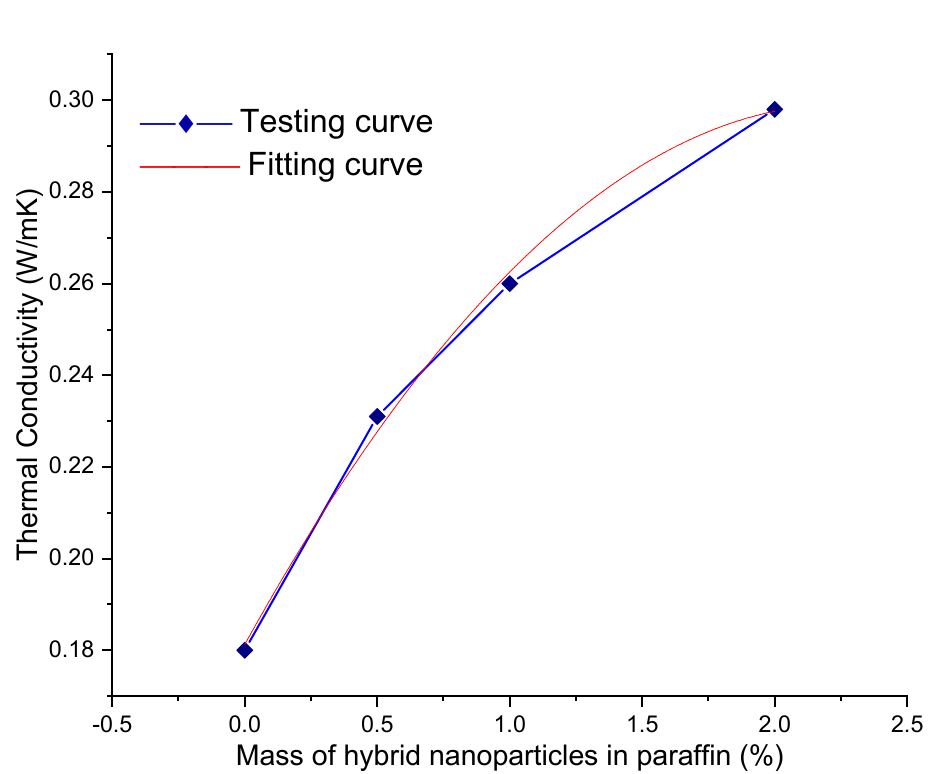
Figure 9. Thermal conductivity of the hybrid-nano/paraffin samples.